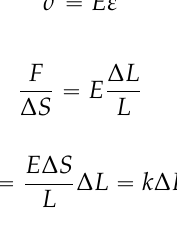
Figure 5. Diagram of the mechanical vibration applied to the fiber coil. The vibration direction is along the z -axis and perpendicular to the fiber coil.